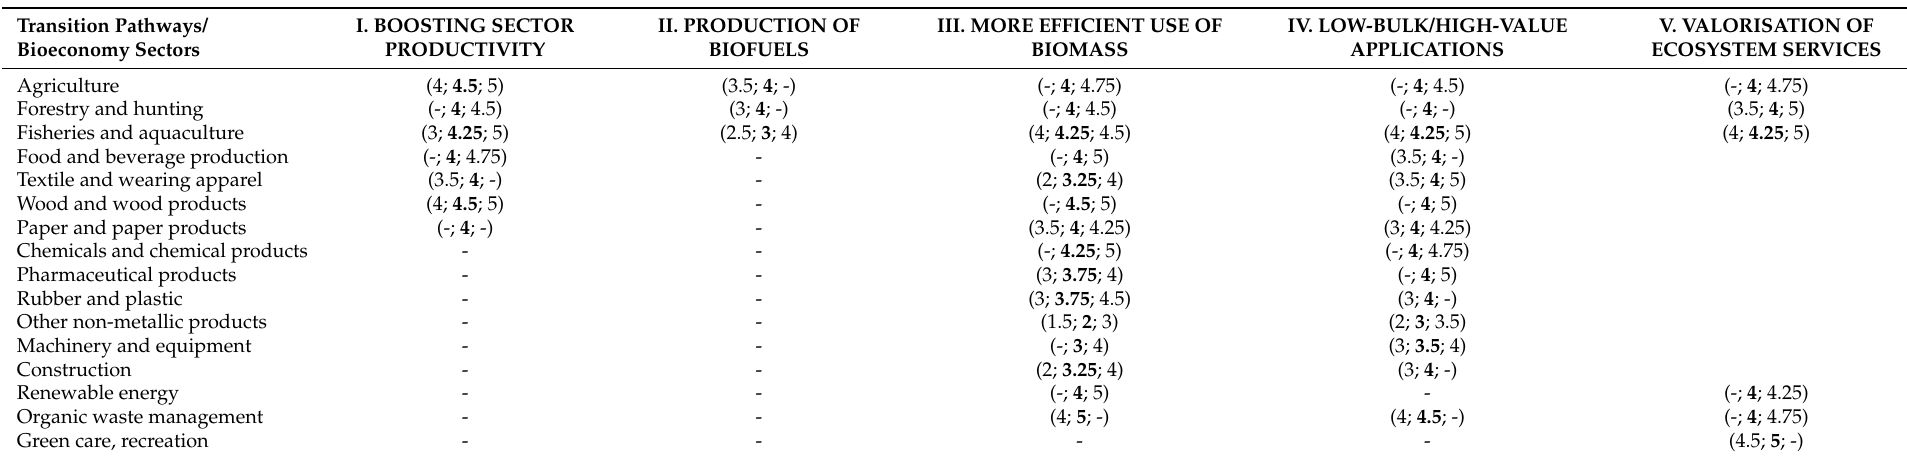
Table 1. Assessing the relevance of various transition pathways for bioeconomy sectors in CEE countries—results of the BIOEASTsUP expert survey [67]. Transition Pathways/ Bioeconomy